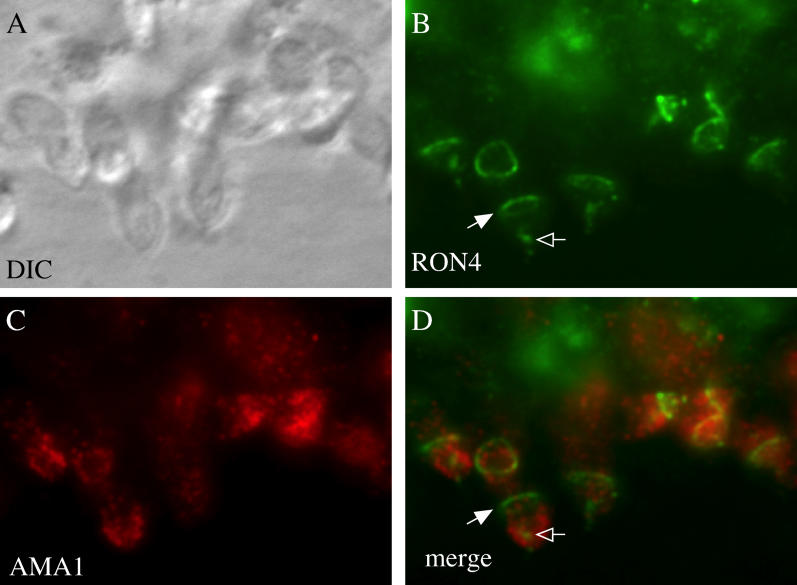
Localization of RON4 and TgAMA1 During EgressDIC (A) and IIF (B, C, and D) were used to image wild-type tachyzoites fixed with formaldehyde one minute after calcium-ionophore treatment to induce egress, and permeabilized with triton X-100. (B) and (C) show staining with anti-RON4 (FITC) and anti-TgAMA1 (Texas Red), respectively. (D) is the merged image. Antibody and IIF details are as for Figure 4.